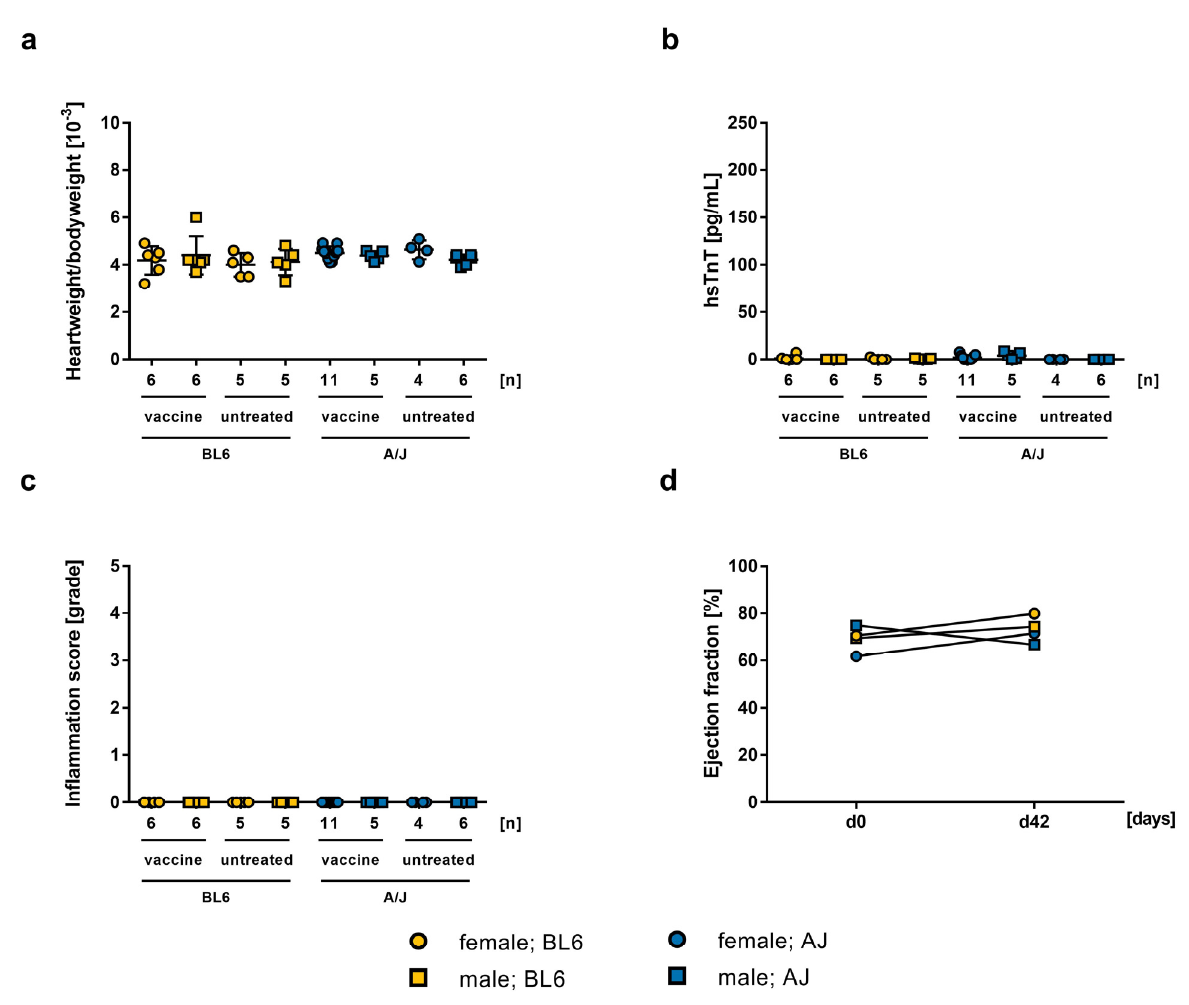
Figure 4. Strain specific differences (BL/6 vs. A/J) of 2.5 µg mRNA-vaccination. Data is presented as a mean ± SEM (vaccine n = 6, untreated n = 5). ( a ) Comparison of heart weight to body weight ratio on day 42. ( b ) Measured hsTnT-levels in mouse sera collected on day 42. ( c ) Histopathological examination of inflammation score in grades in HE stained heart sections on day 42, evaluated by two independent investigators. ( d ) Echocardiographic assessment of ejection fraction using M-mode on day 0 and day 42.